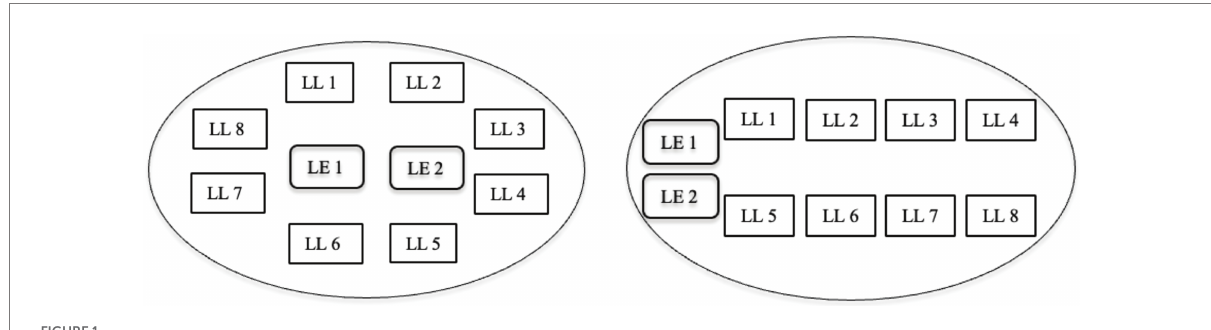
FIGURE 1 Classroom